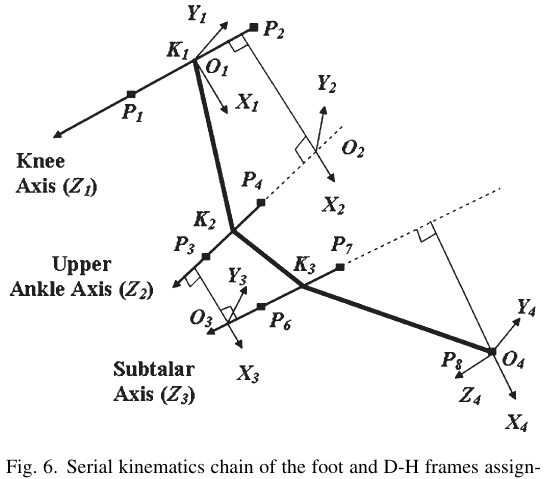
Fig. 5. Main rotation axes of the ankle.